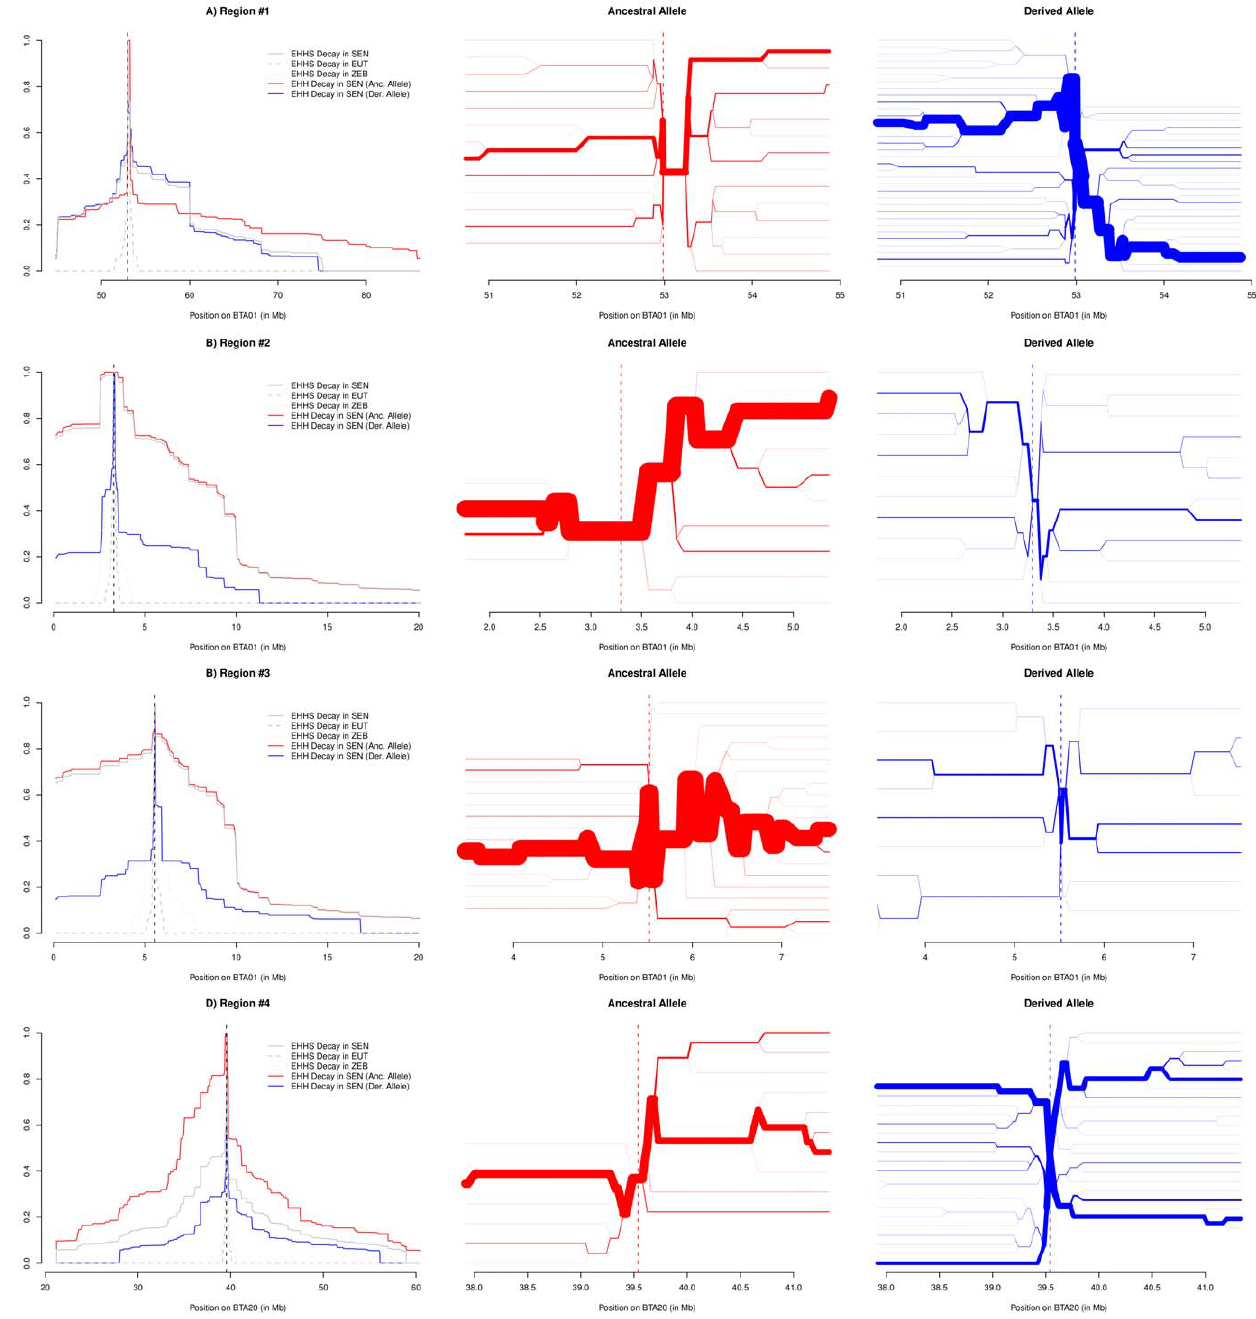
Figure 3. Details of the haplotype structure within the four significant footprints of selection identified. For each of the four regions, the decays of EHH (SEN ancestral and derived allele) and EHHS (for SEN, EUT and ZEB populations) from the core SNP located under the peak position are plotted in the leftmost panel. Haplotype bifurcation diagrams for both the ancestral (in red in the center panel) and derived allele (in blue in the rightmost panel) are also represented. disease in African livestock and its obligate vector (the tsetse fly) are absent in South America. SEN cattle are already present in South Africa, Botswana, Namibia and Zimbawe and some other African countries are planning to import SEN animals because they are more productive under tropical conditions than local breeds in a tsetse free context. It might be highly advisable to limit SEN importation to countries or areas outside of the tsetse belt.